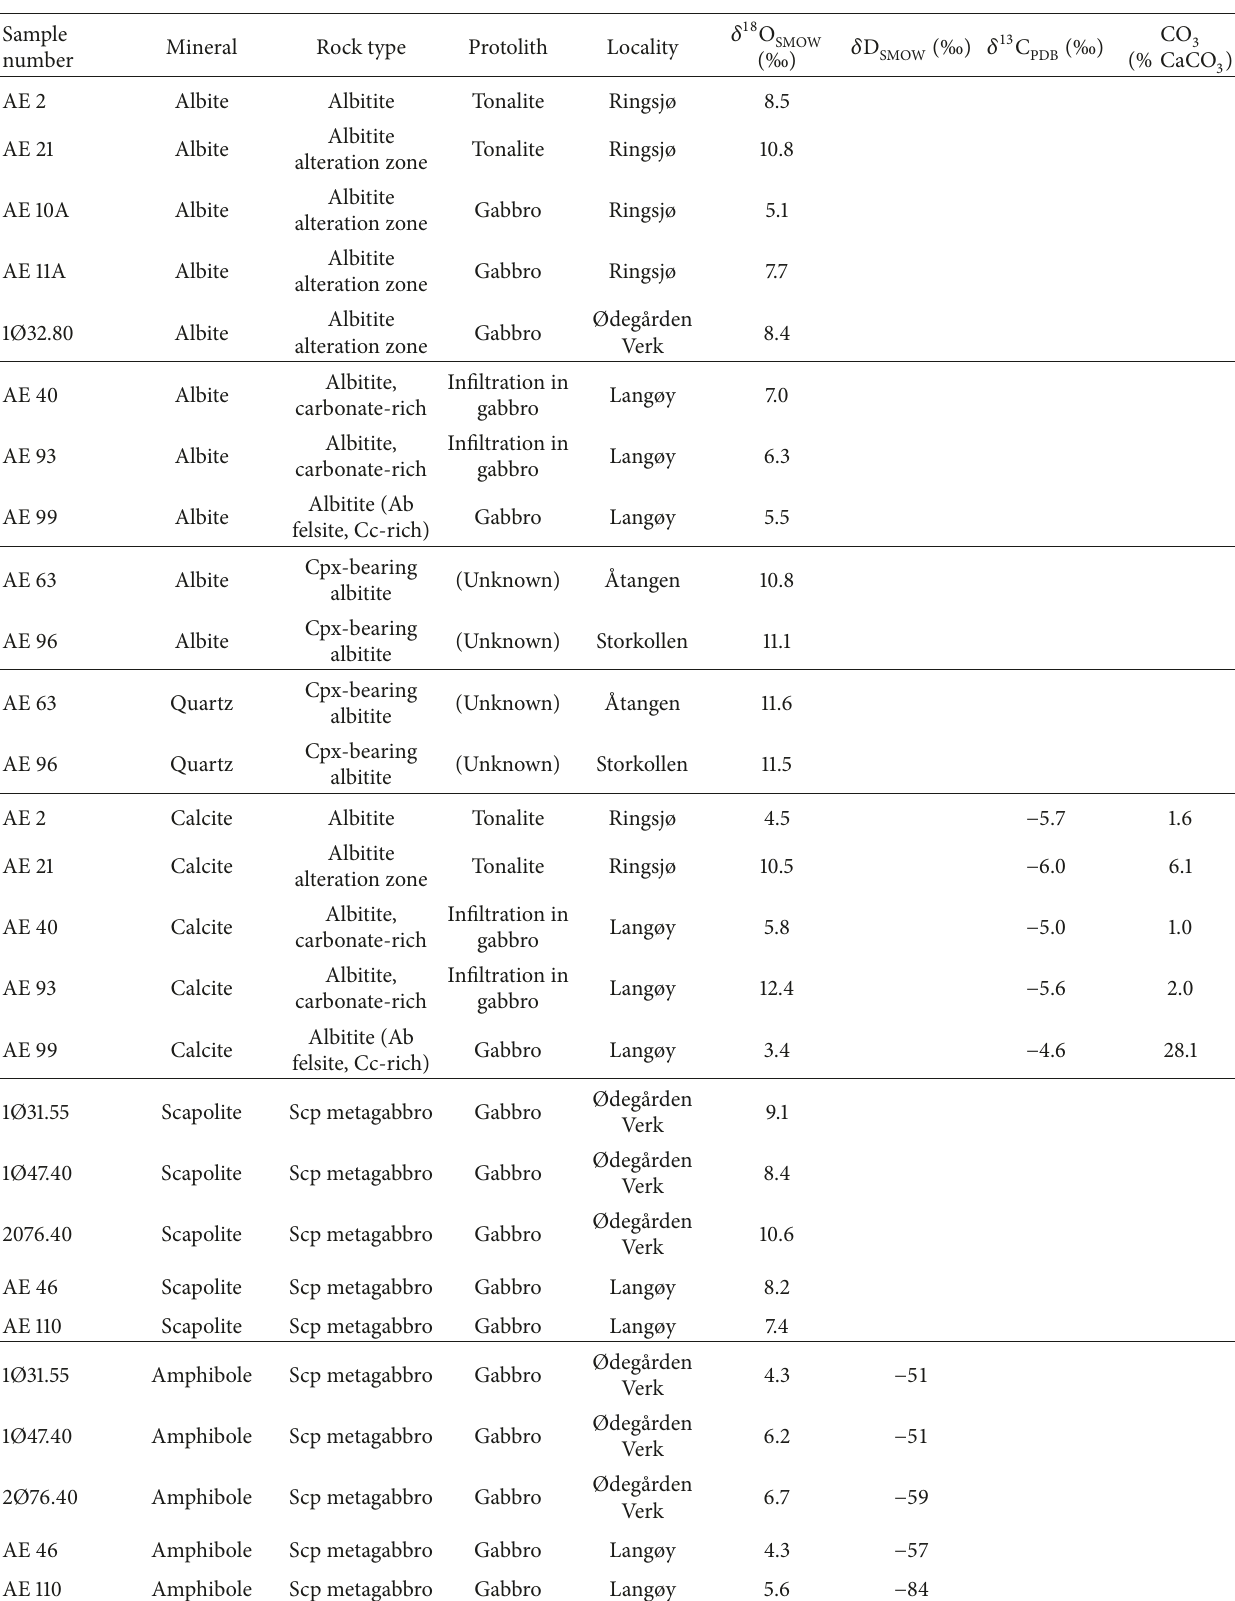
Table 3: Stable isotopic